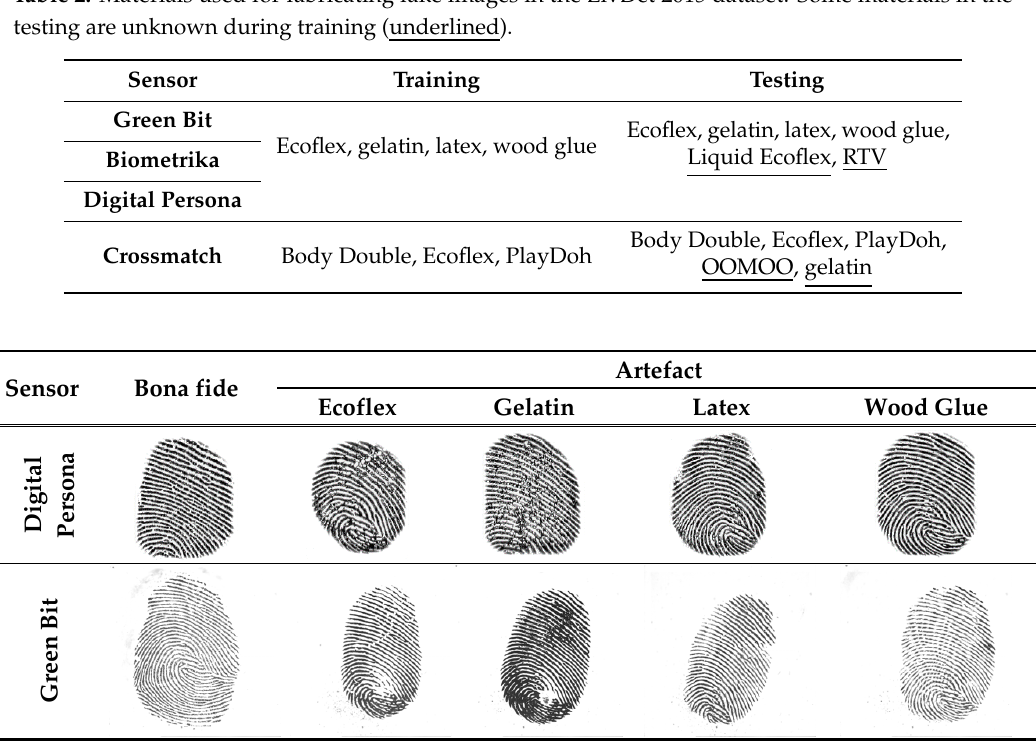
Figure 8. Bona fide and artefact fingerprint samples from the LivDet 2015 dataset captured using Digital Person and Green Bit sensors. Artefact samples were fabricated using different materials.